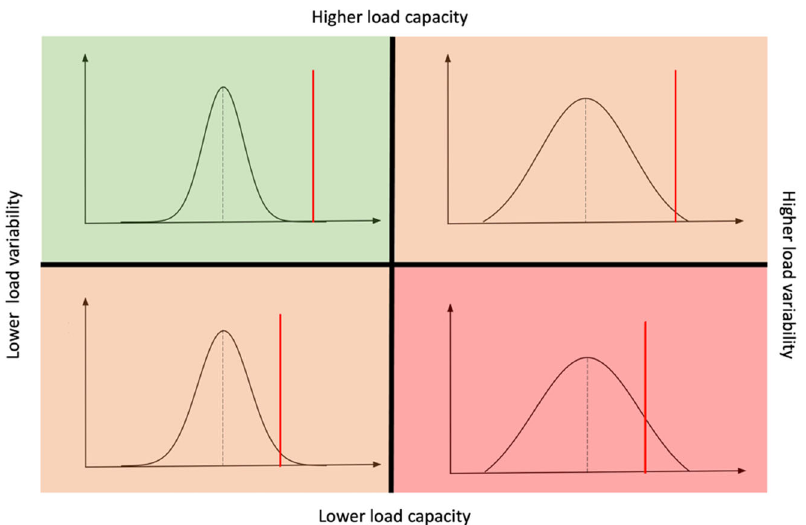
Figure 2. Schematic overview of within-individual elbow load variability (width of the normal distributions) and injury thresholds (red vertical lines). All four quadrants have the same load magnitude (average), shown as the vertical dashed lines. The horizontal axis of the quadrant shows the load variability, and the vertical axis shows the load capacity. The state on the left top panel shows the lowest chance, the right top and left bottom have the same chance, and the right bottom has the highest chance of sustaining an injury. Be aware that a shift in the load magnitude is also possible, but not represented here.